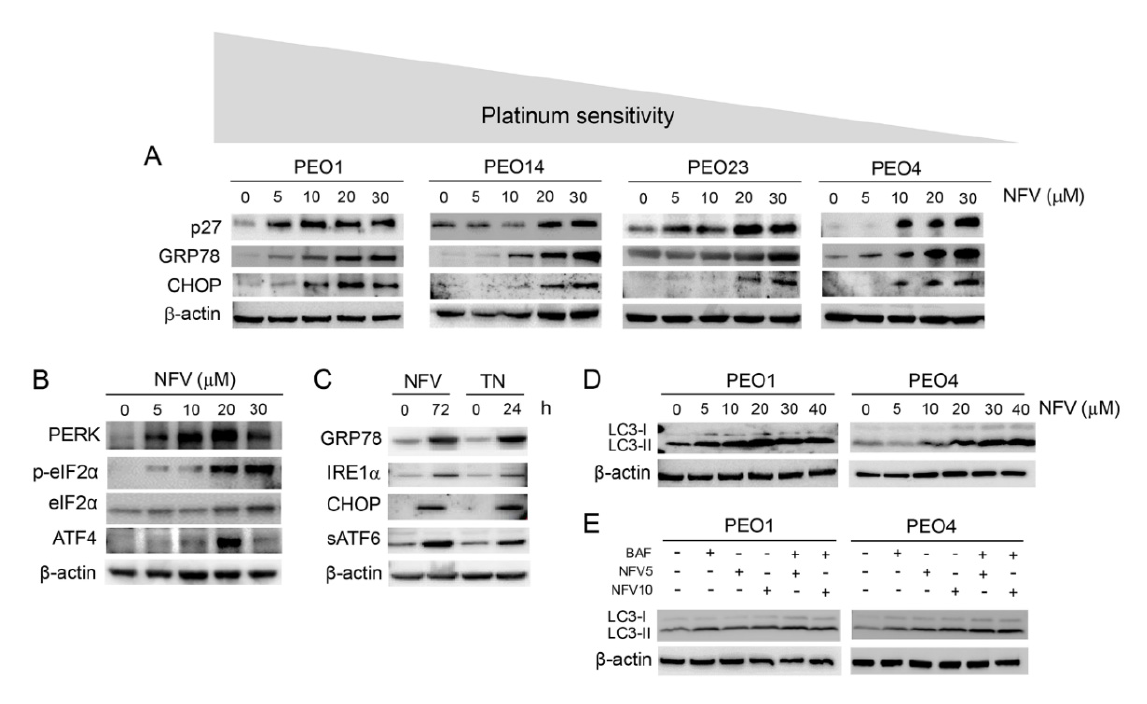
Figure 2. ( A ) PEO cells with different sensitivities to cisplatin were exposed to 5, 10, 20, or 30 µ M nelfinavir (NFV) for 72 h. In all cell lines, NFV increased the expression of cell cycle inhibitor p27 kip1 , and ER stress related proteins GRP78, and CHOP. The gray area that goes from higher to lower signifies that the cells are depicted in order of their decreasing sensitivity to the toxic effects of cisplatin as shown in Table 1. ( B ) Expression of proteins involved in the ER response as studied in PEO1 cells exposed to various doses of NFV for 72 h. ( C ) Exposure of PEO1 cells to 20 µ M NFV for 72 h increases ER stress-related proteins in a similar manner than 2 µ g/mL of the known ER stressor tunicamycin (TN) does after 24 h exposure. ( D ) In PEO1 and PEO4 cells treated with various concentrations of NVF for 72 h, the autophagosome-related protein LC3II increases in response to NFV in a concentration-dependent manner. ( E ) PEO1 and PEO4 cells were treated with 5 or 10 µ M NFV for 72 h, in the absence or presence of 100 nM of the lysosome inhibitor bafilomycin A1 (BAF), which was added 1 h before the termination of the experiment. In both PEO1 and PEO4 cells, the induction of LC3II triggered by NFV was not augmented further by the presence of BAF. All results presented are representative of at least two independent experiments that had a similar outcome. NFV5, 5 µM NFV; NFV10, 10 µM NFV.